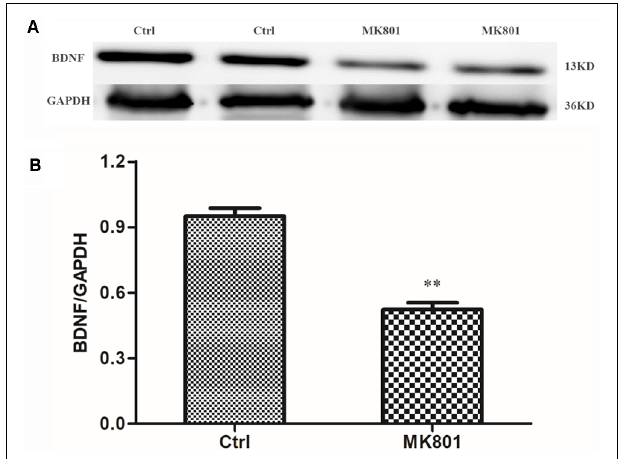
FIGURE 6 | Risperidone reverses the MK801-induced decrease in retention latency in rats. MK-801 was administered by injection (0.5 mg/kg body weight, i.p.) once daily for 6 days. Subsequently, rats in the MK-801+ risperidone group were injected with risperidone (1 mg/kg body weight, i.p.) once daily for 7 days whereas the MK-801-only group received an equal volume of normal saline. Control group received an equal volume of normal saline once daily for 13 days. Retention latency was evaluated with the inhibitory avoidance (IA) test. Data are shown as mean ± SEM. ∗ P < 0.05 vs. control group; # P < 0.05 vs. MK801